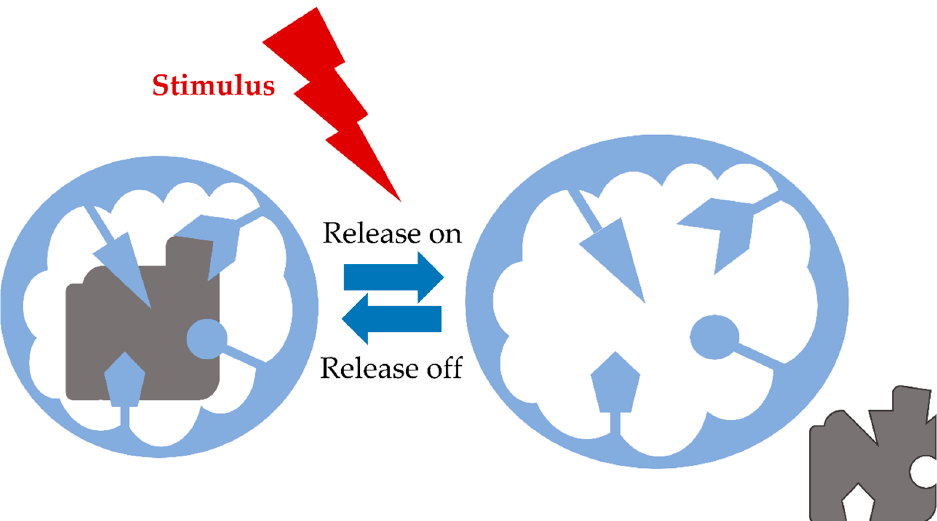
Figure 11. Schematic view of the effect of a stimulus on the conformation of the drug-imprinted cavities in a responsive hydrogel.